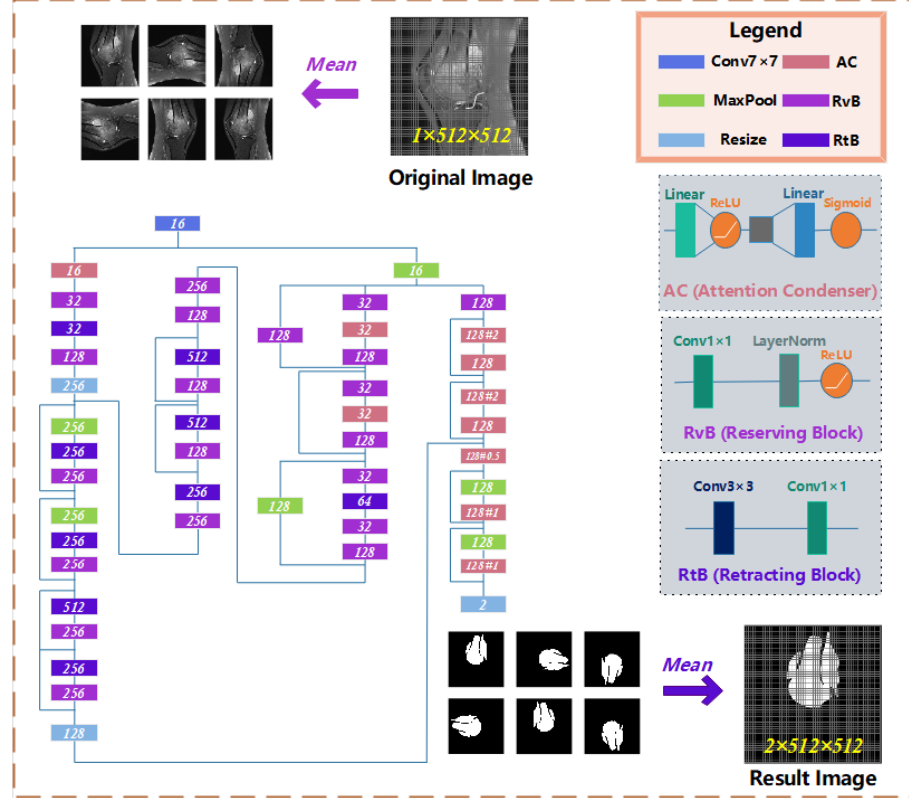
Figure 4. The architecture of osteosarcoma segmentation network ACRNet.